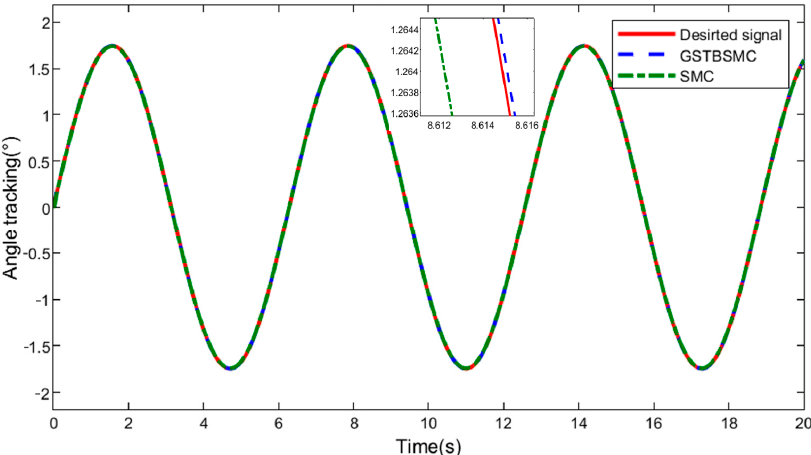
Figure 8. Comparison of the tracking e ff ect of GSTBSMC and SMC in Experiment 1.